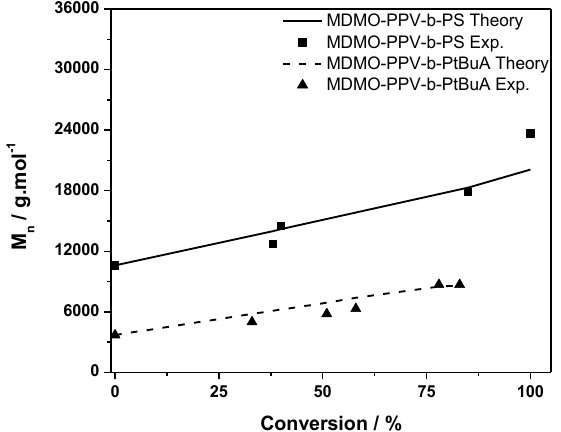
Figure 6 . The dependence of the molecular weight M n upon the conversion for the MDMO- PPV- b -PtBuA and MDMO-PPV- b -PS block copolymers. Markers represent experimental M n values, the lines theoretical M n